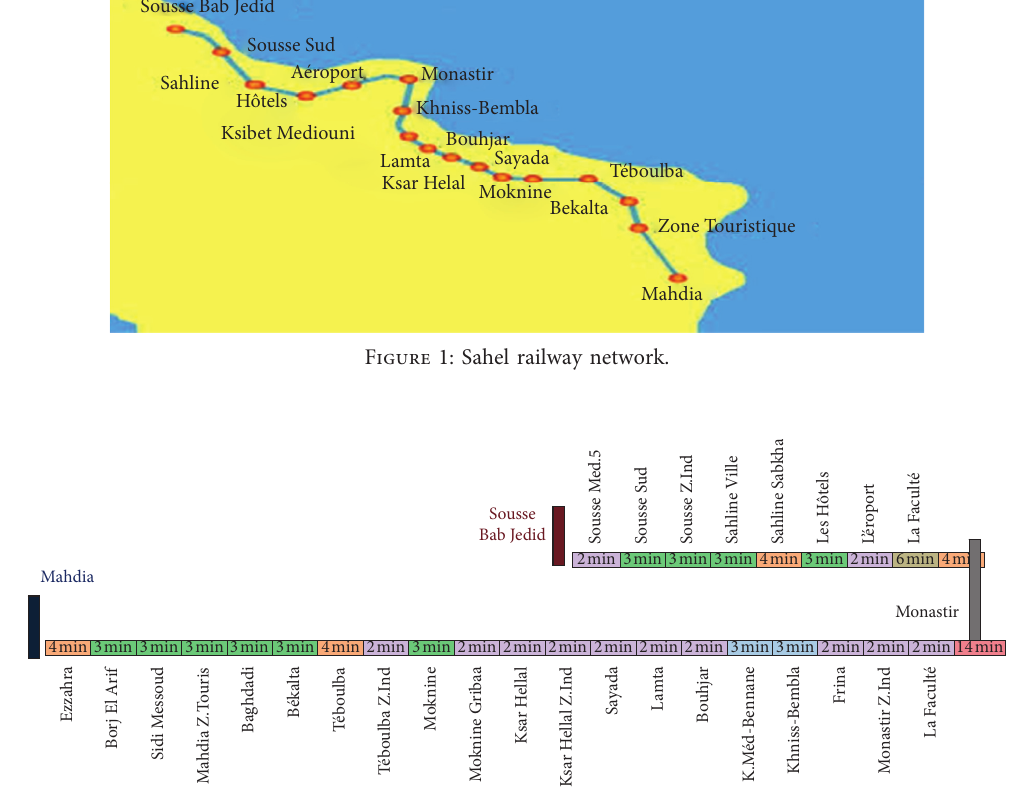
Figure 2: Travel times between stations belonging to the Sahel railway transport